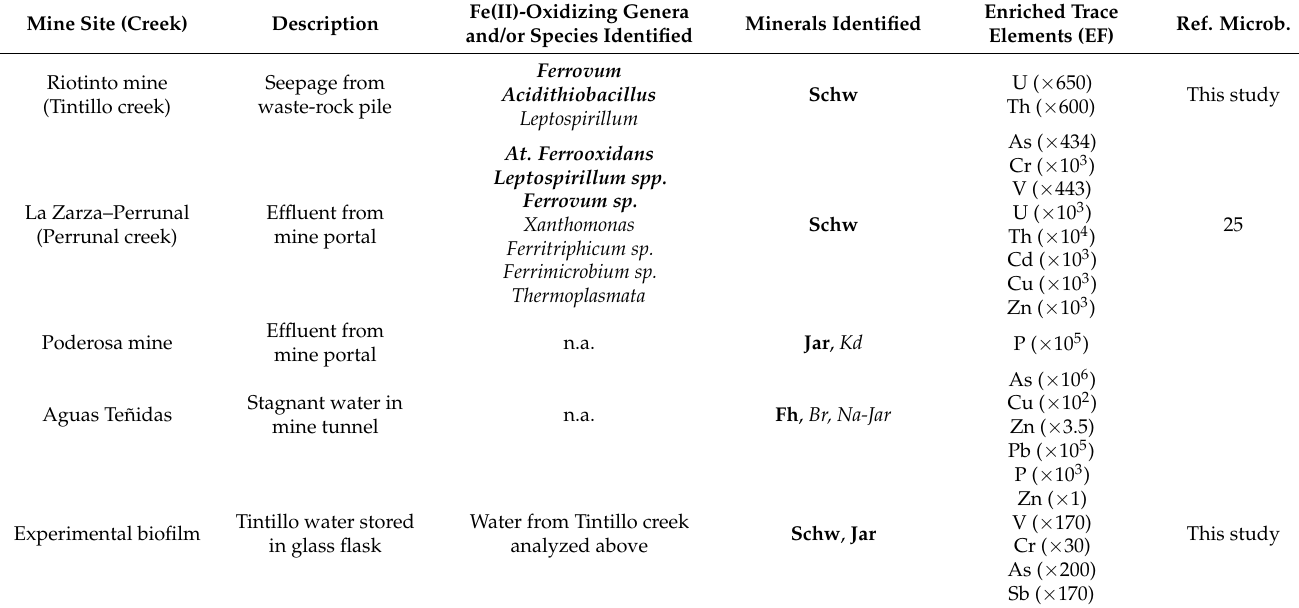
Table 4. Compilation of Fe(II)-oxidizing microorganisms, iron-rich minerals and enriched metals identified in FMF-forming acidic mine waters of the IPB. Microorganisms and minerals in bold are dominant, whereas those in italics are accessory.